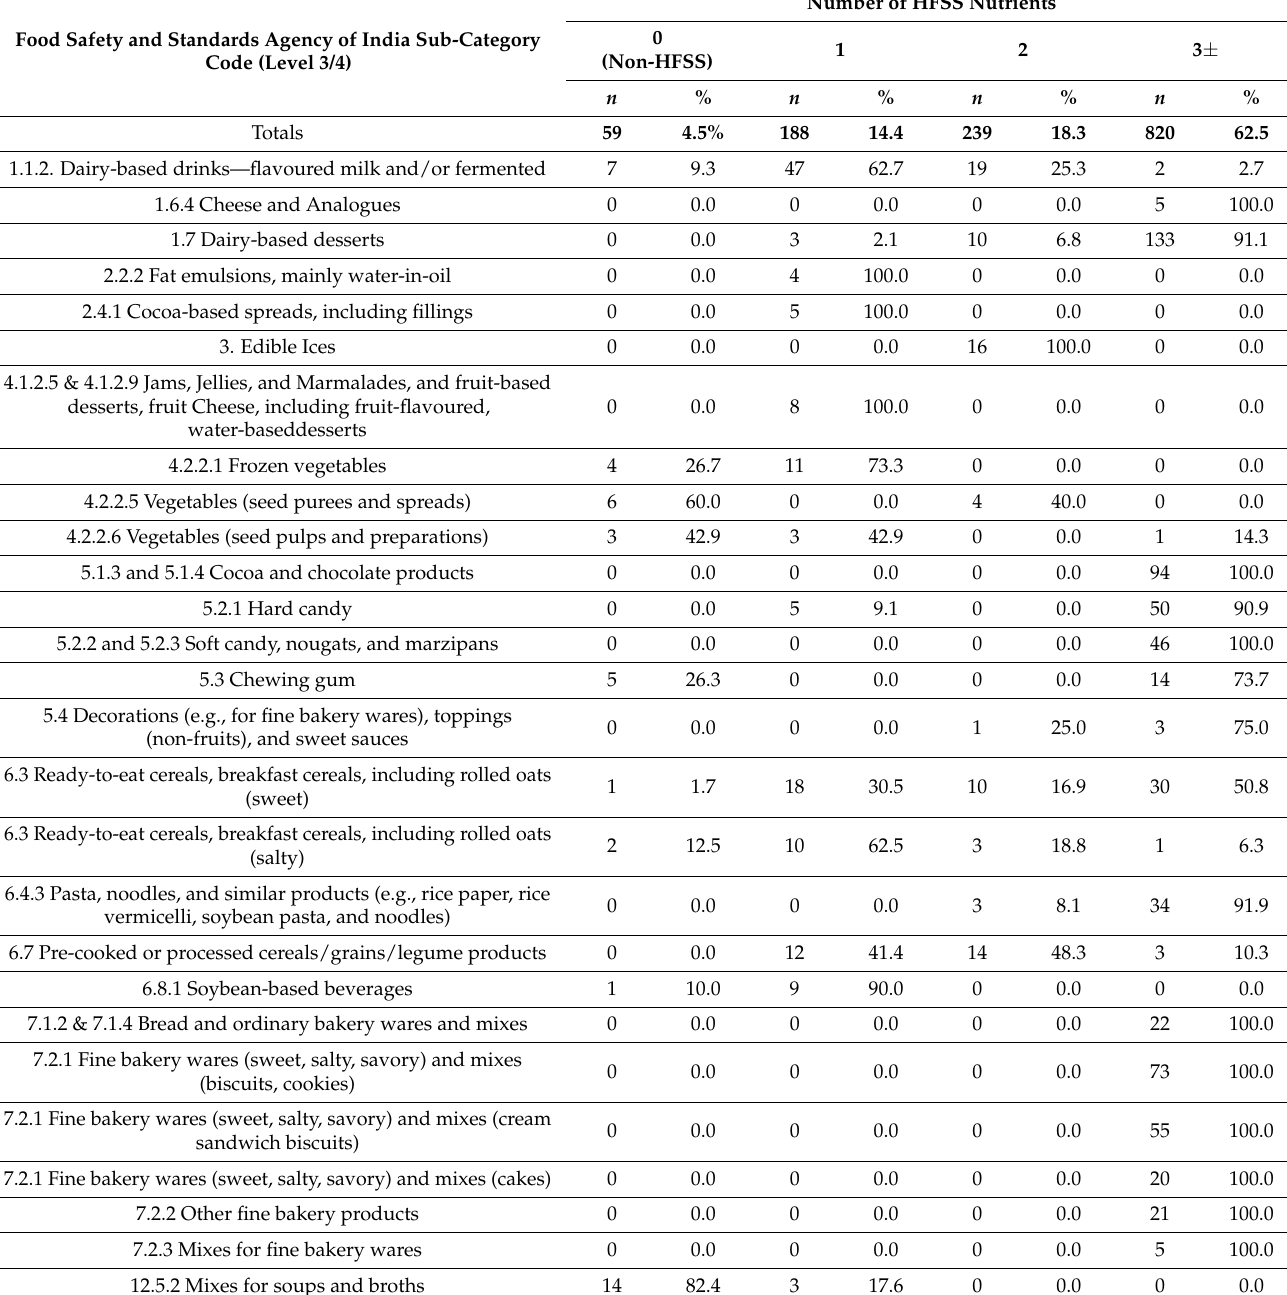
Table 3. Number (%) of products (per category) containing 0 nutrients/1 nutrient/2 nutrients/3+ nutrients high in sugar, saturated fat, or sodium (HFSS) foods and beverages.